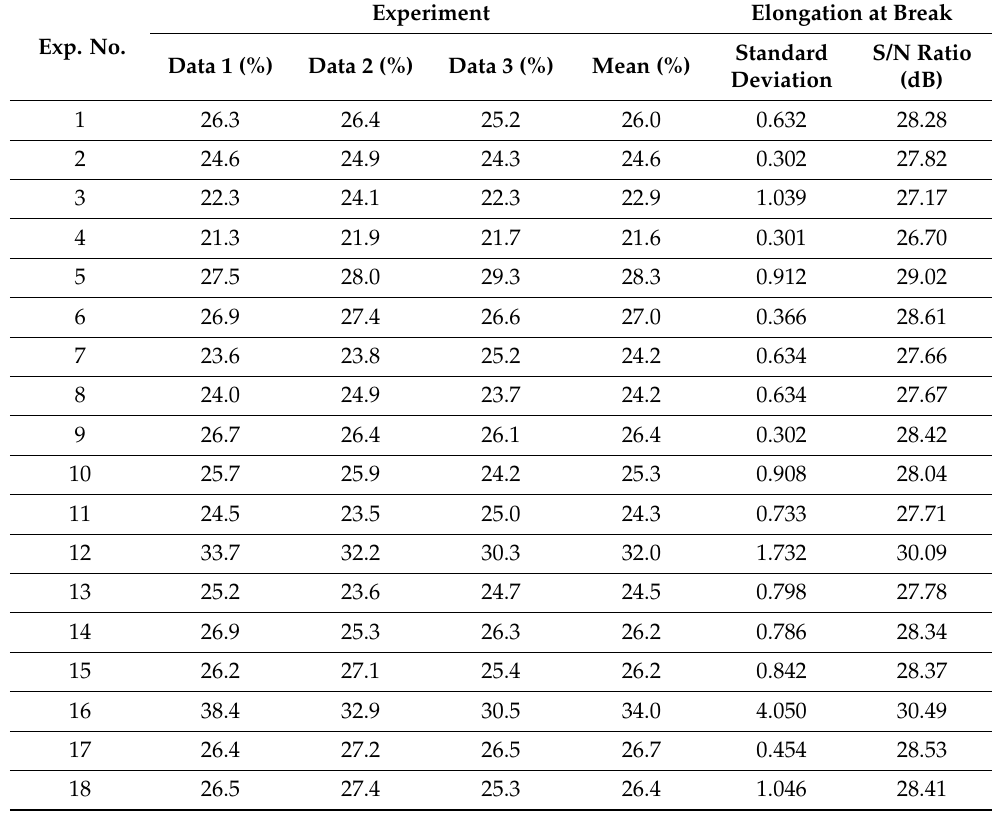
Table 11. Experimental data of elongation at break.